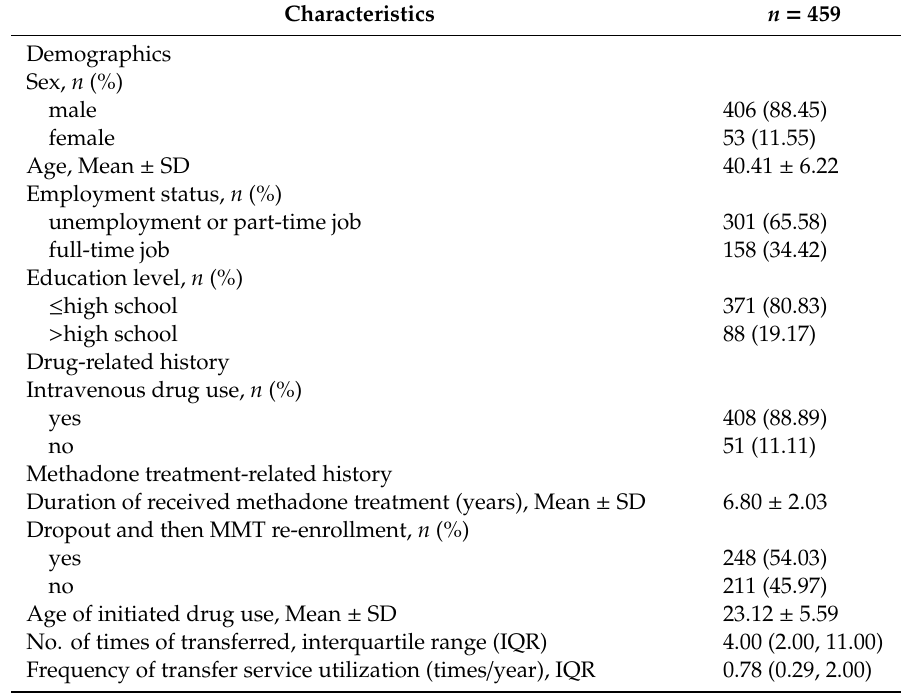
Table 1. Individual characteristics and methadone maintenance treatment (MMT) history (level